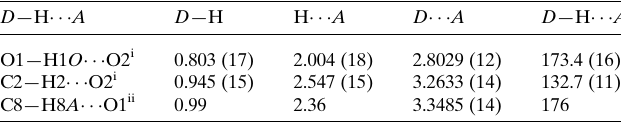
Table 1 Hydrogen-bond geometry (A˚ , (cid:4) ).